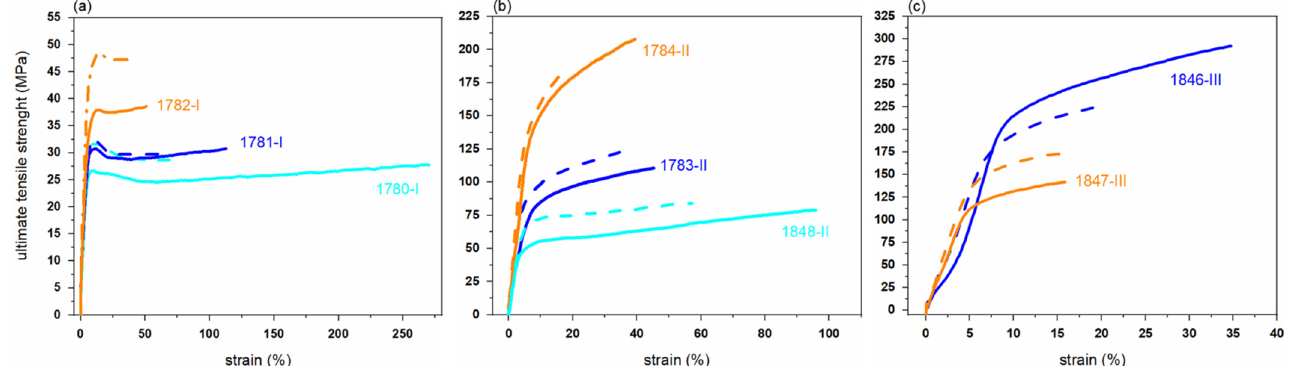
Figure 8. Stress-strain curves of PHBH monofilaments produced from grade ( a ) I, ( b ) II, ( c ) III. Measurements of aged (33 monts) fibers are shown as dashed curves.